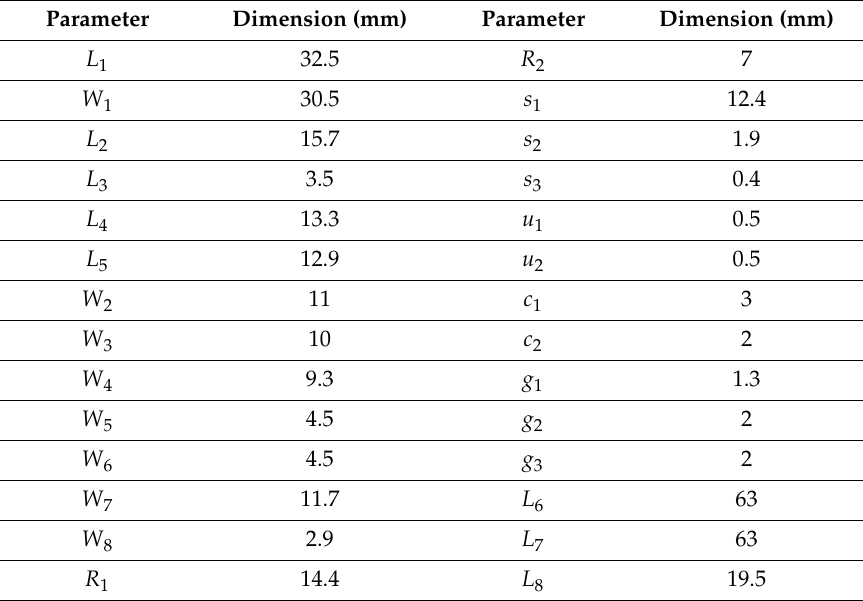
Figure 1. Layout of the truncated–semi-elliptical–self-complementary (TSESC) resonating element. Table 1. Proposed TSESC antenna